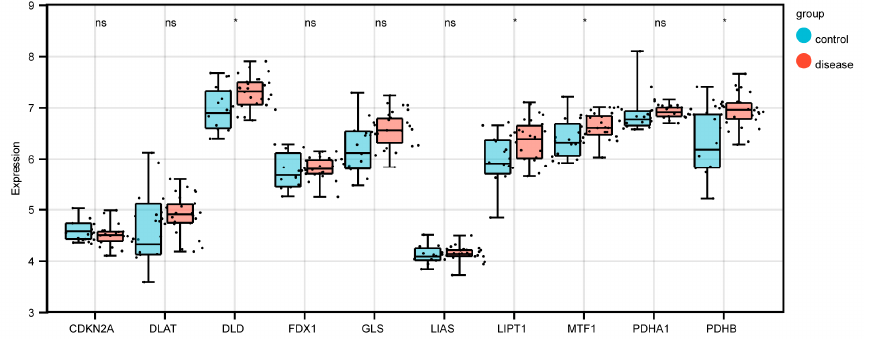
Figure 10. Boxplot of copper death-related gene expression between the disease samples and control samples (* p < samples (* p < 0.05).